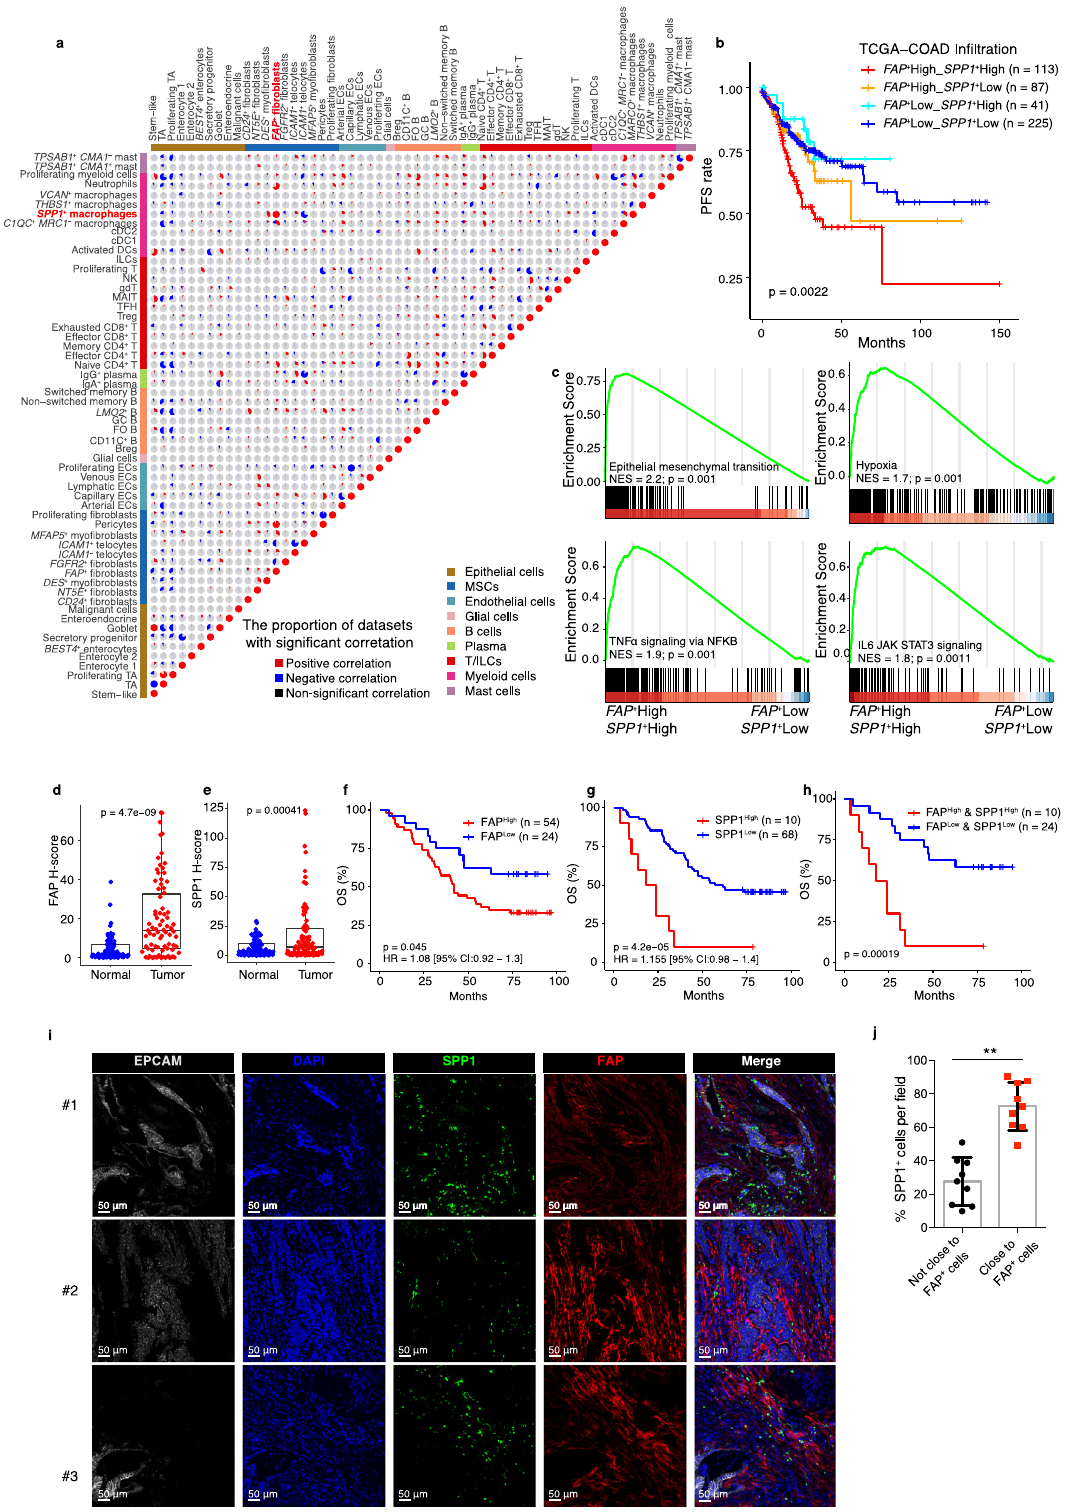
further identify the key mediators of FAP + fi broblasts and SPP1 + macrophages interaction in CRC patients, we investigated the cell – cell communication mechanisms of FAP + fi broblasts and SPP1 + macrophages. To this end, we evaluated the putative crosstalk with the R package “ NicheNet ” based on the expression and downstream targets of ligand-receptor pairs 61 . We found that FAP + fi broblasts could directly contact with SPP1 +